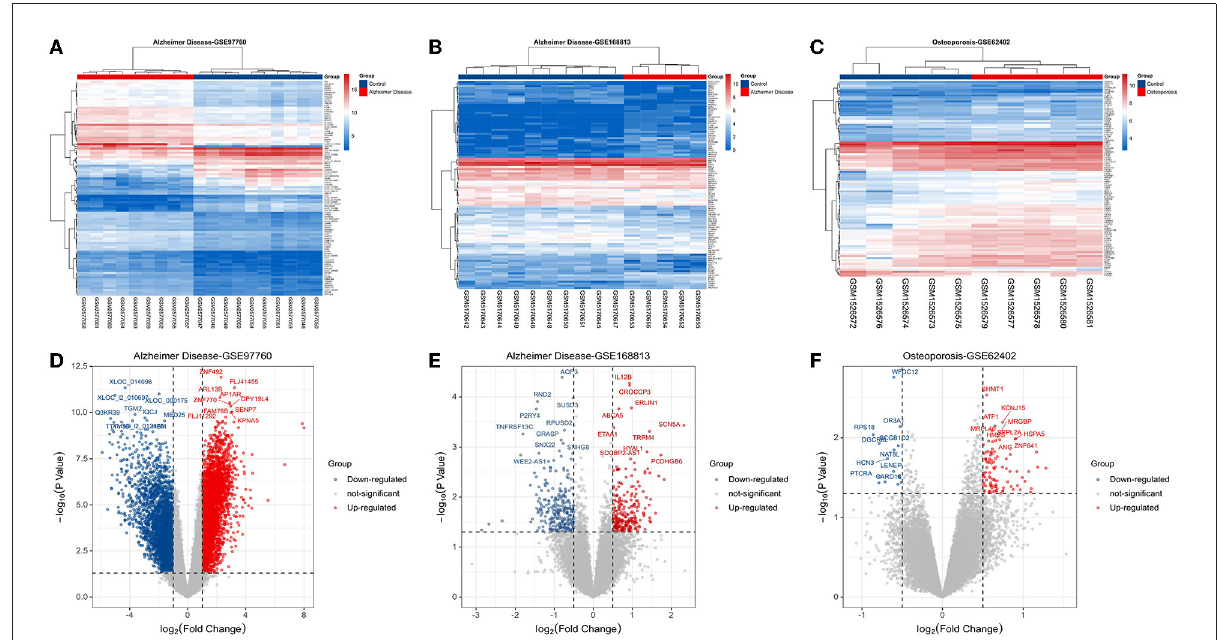
FIGURE1 Disease target screening. (A) Heat map of differentially expressed genes in GSE97760; (B) heat map of differentially expressed genes in GSE168813; (C) heat map of differentially expressed genes in GSE62402; (D) volcano map of differentially expressed genes in GSE97760; (E) volcano map of differentially expressed genes in GSE168813; (F) volcano map of differentially expressed genes in